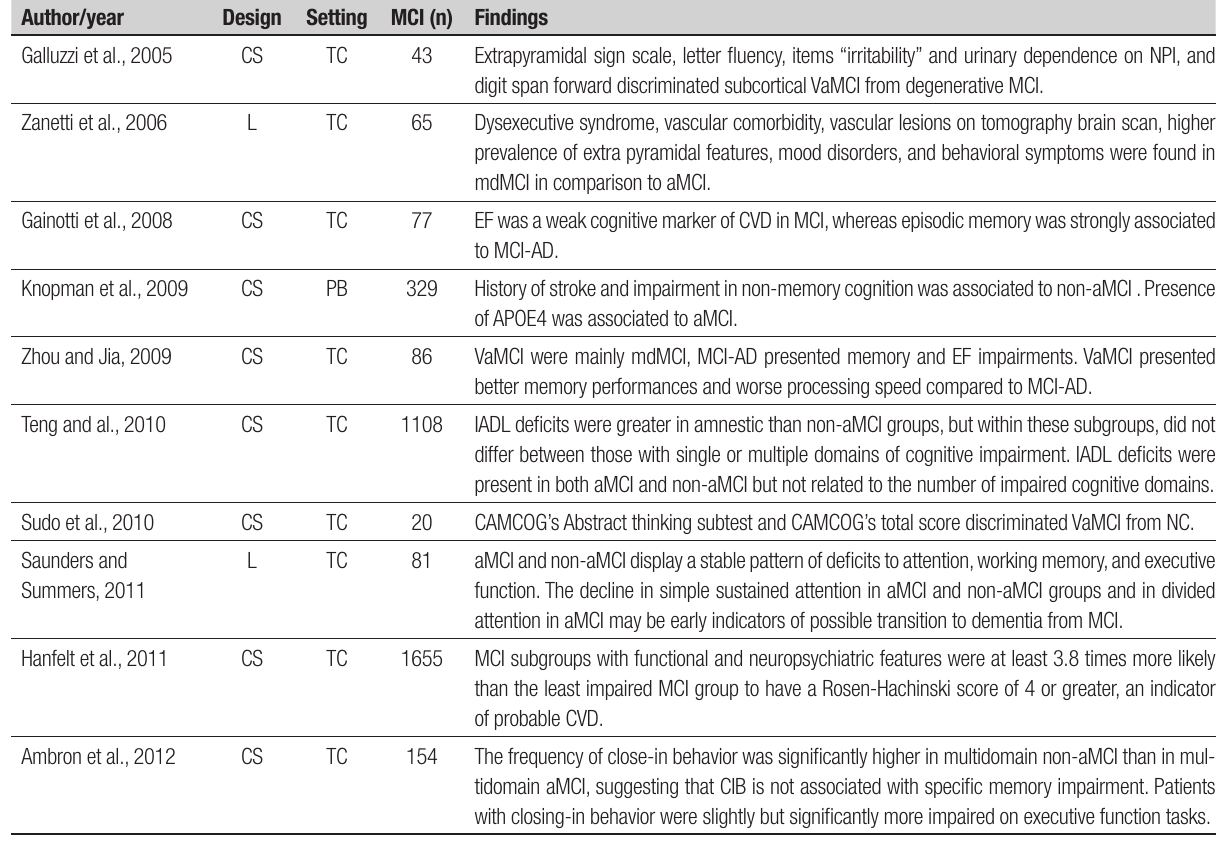
Table 1. Characteristics of studies on clinical and neuropsychological aspects of non-amnestic VaMCI included in this review.